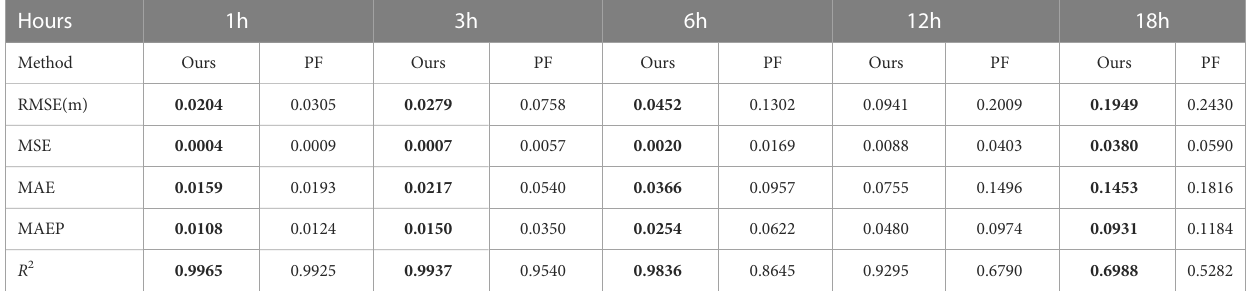
Bold values in the table indicate optimal